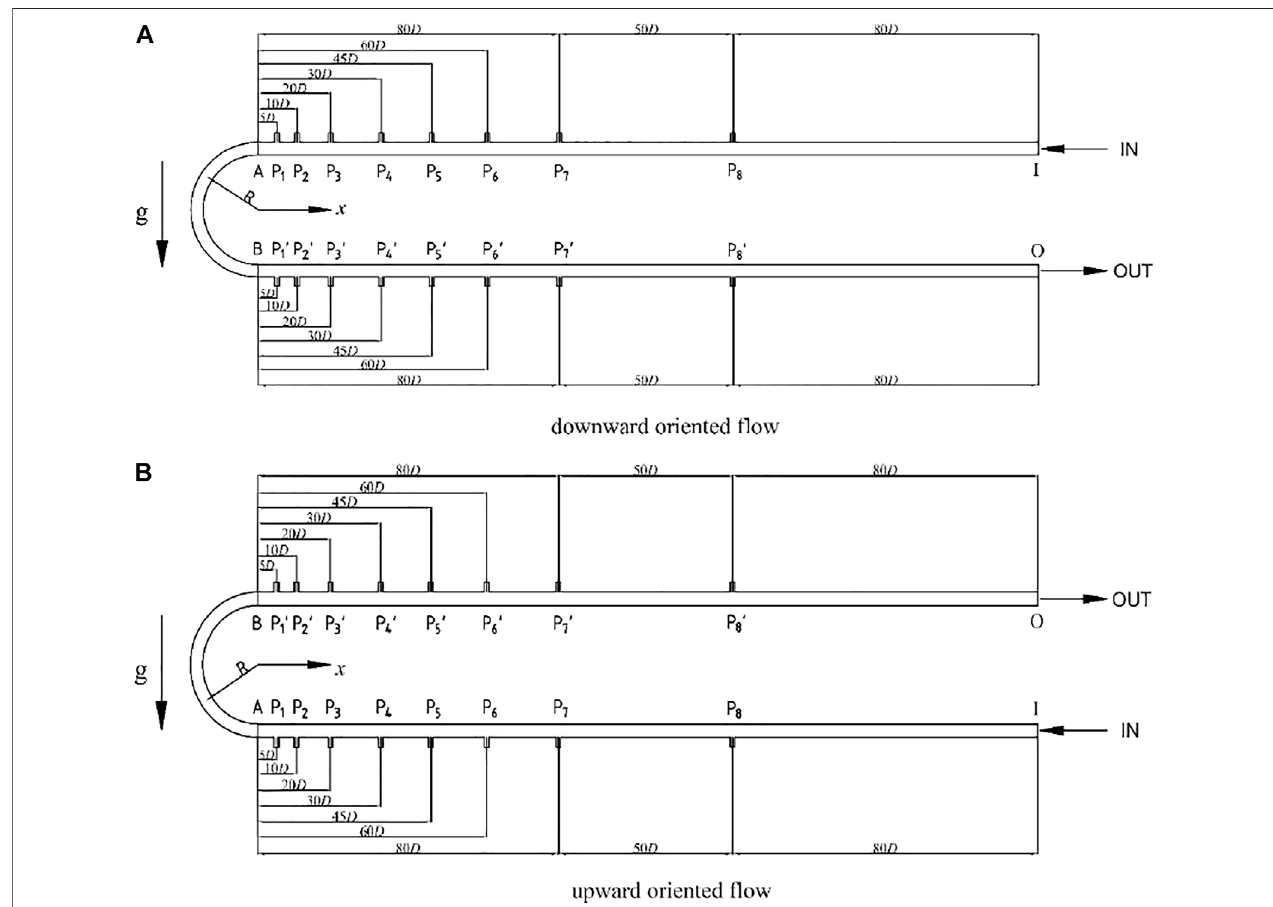
FIGURE 3 | Physical picture of a test